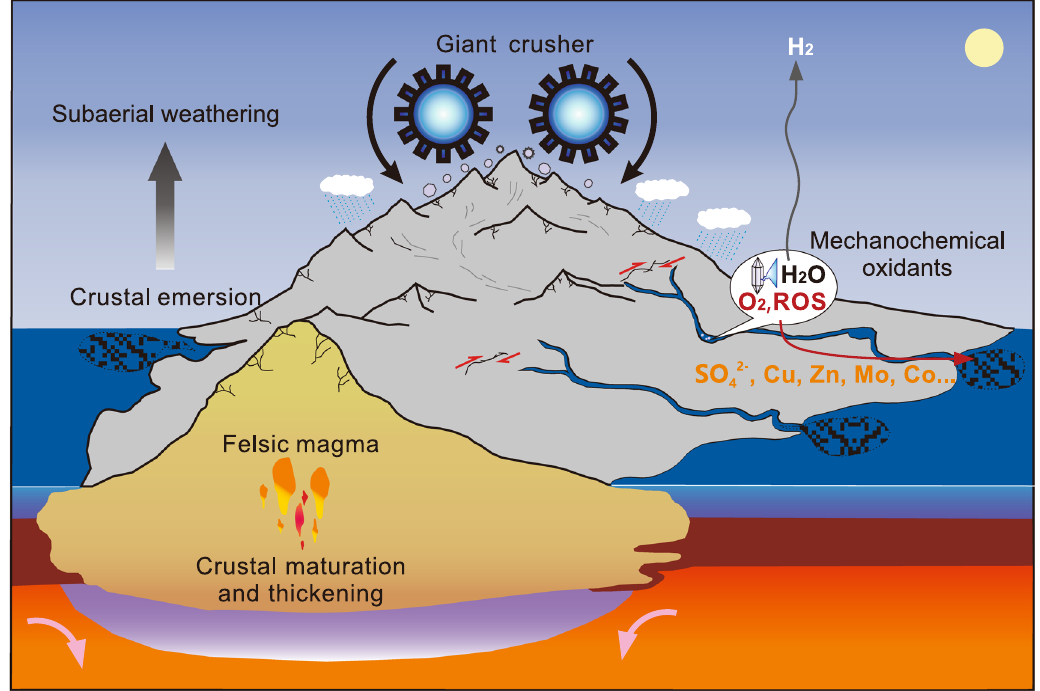
Fig. 3 Schematic of ROS production during erosion of exposed Archean landmass. During early crustal thickening of cratons, formation and emplacement of voluminous felsic rocks provided large positive buoyancy, resulting in elevated topography and high denudation rates. This geodynamic process runs like a giant crushing machine, and crust uplifting fed the felsic rocks to tectonic denudation and physical weathering, in which ROS are generated during transport from land to the oceans. Those regions with intensive physical weathering may have acted as an effective “ oxygen-producing factory ” on the Archean terrestrial surface. A possible side-effect was localized oxidative weathering and supply of dissolved oxidized species ( e.g ., sulfate, molybdate) to the